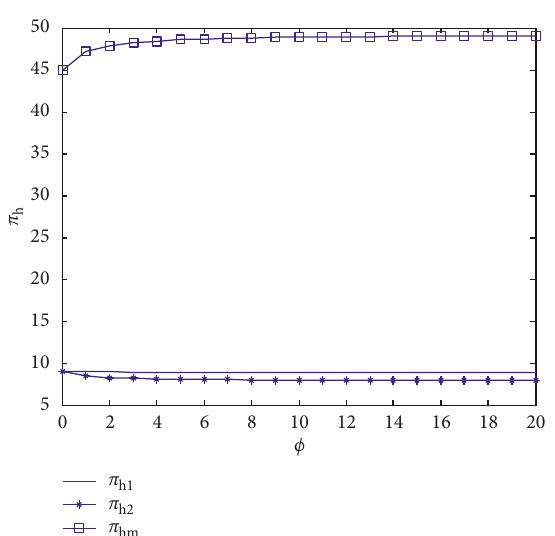
Figure 6: Impacts of horizontal fairness concern on the profit of supply chain.